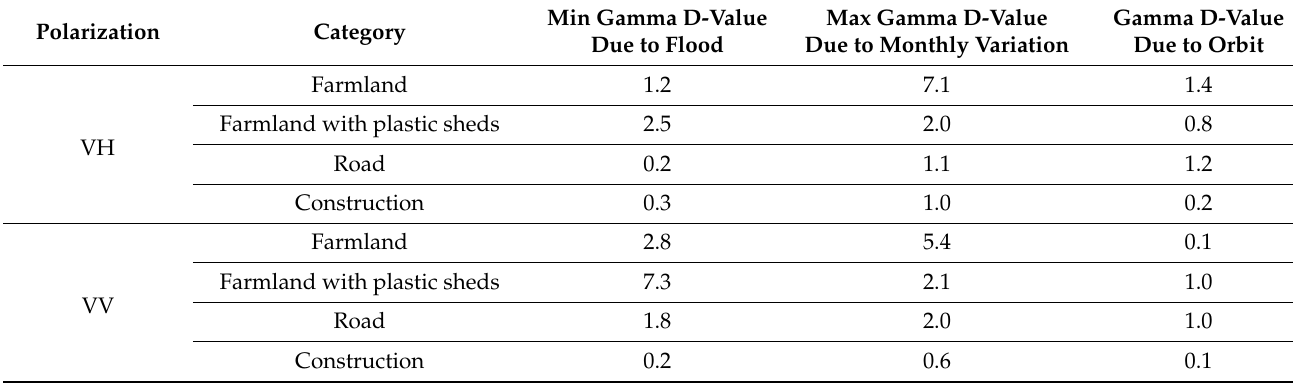
Table 8. Influence of monthly variation and orbit on flood extraction (Unit: